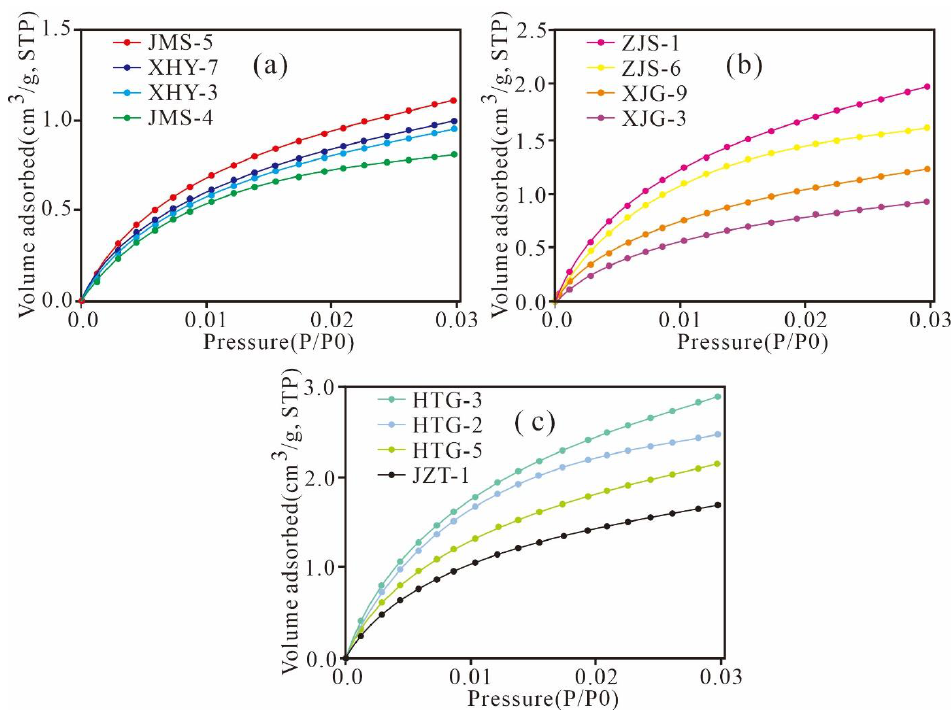
Figure 5. CO 2 adsorption isotherms of the Mesoproterozoic Xiamaling shale in Zhangjiakou, Hebei (( a ), TOC < 1.0% ; ( b ), 1.0% < TOC < 3.0% ; ( c ), TOC > 3.0%). The micropore size distribution of the Xiamaling shale obtained by the DFT model exhibits a high log differential PV and SA and similar distribution characteristics (Figure 6). There are three stable peaks at approximately 0.3~0.4 nm, 0.45 – 0.6 nm and 0.7~1.0 nm, which exhibit the same increasing and decreasing tendencies. The peak values of PV and SA generally increase with TOC content, which indicates a high abundance of micropore distributions of the corresponding pore size, and the abundance of micropores increases with increasing TOC content. Furthermore, micropores sized 0.45 – 0.7 nm are the most prevalent in the distribution, and pores with diameters of approximately 0.3~0.45 nm and 0.7~1.0 nm also significantly contribute to the PV and SA, respectively.